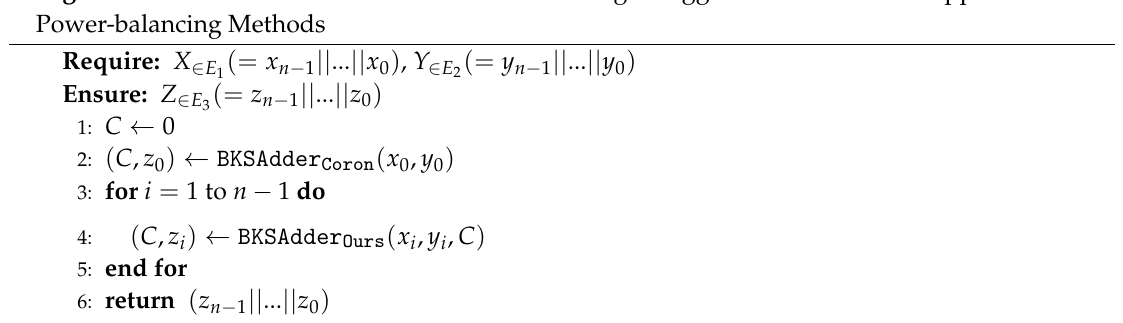
Algorithm 6: Our Multi-bit Adder Combining Kogge–Stone Adders Applied to Power-balancing